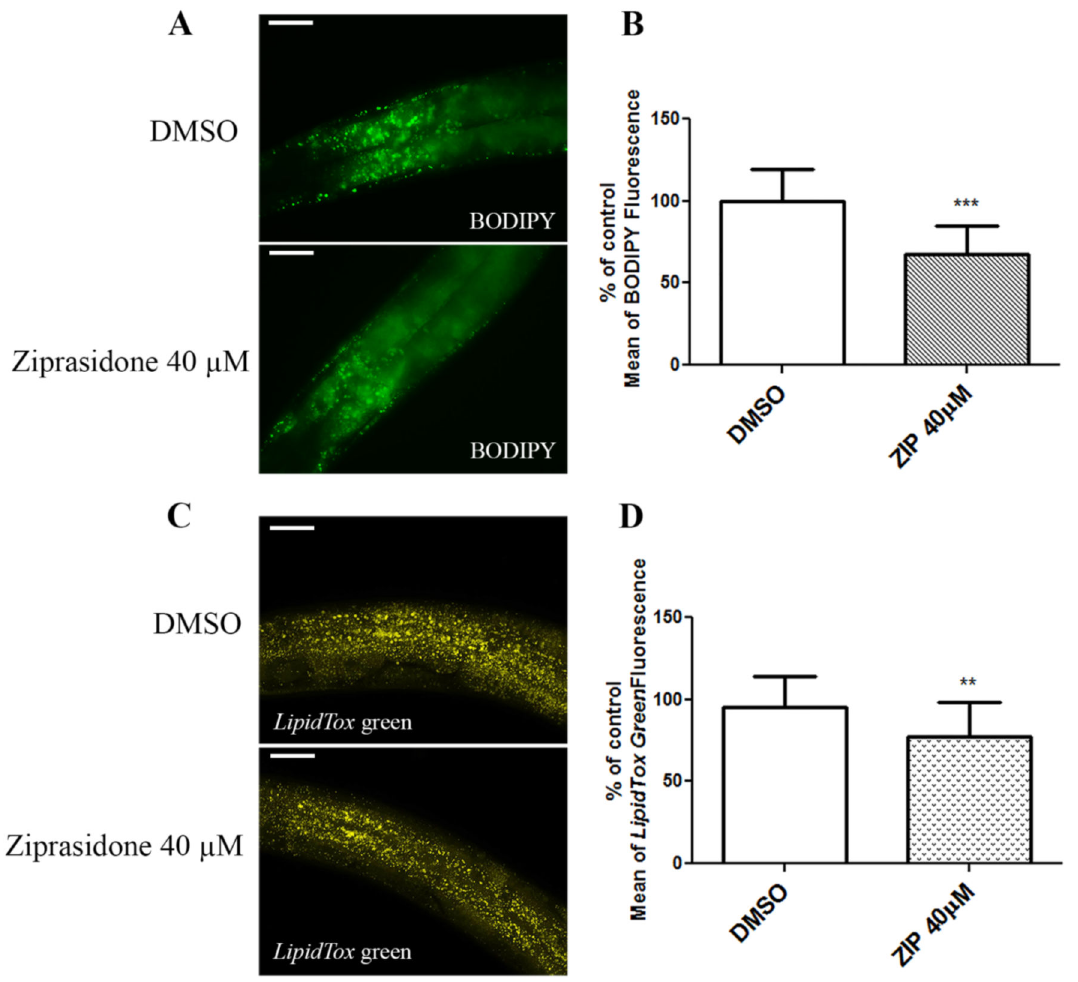
Figure 2. Fluorescence decrease induced by Ziprasidone exposition in Caenorhabditis elegans wild-type (N2) for 24 h. (A) Representative images of fat stores evidenced by BODIPY labeling and (B) fluorescence quantification; (C) Illustrative images and (D) densitometric quantification follow the fluorophore LipidTox Green labeling. The treatment with Ziprasidone (40 µM) or